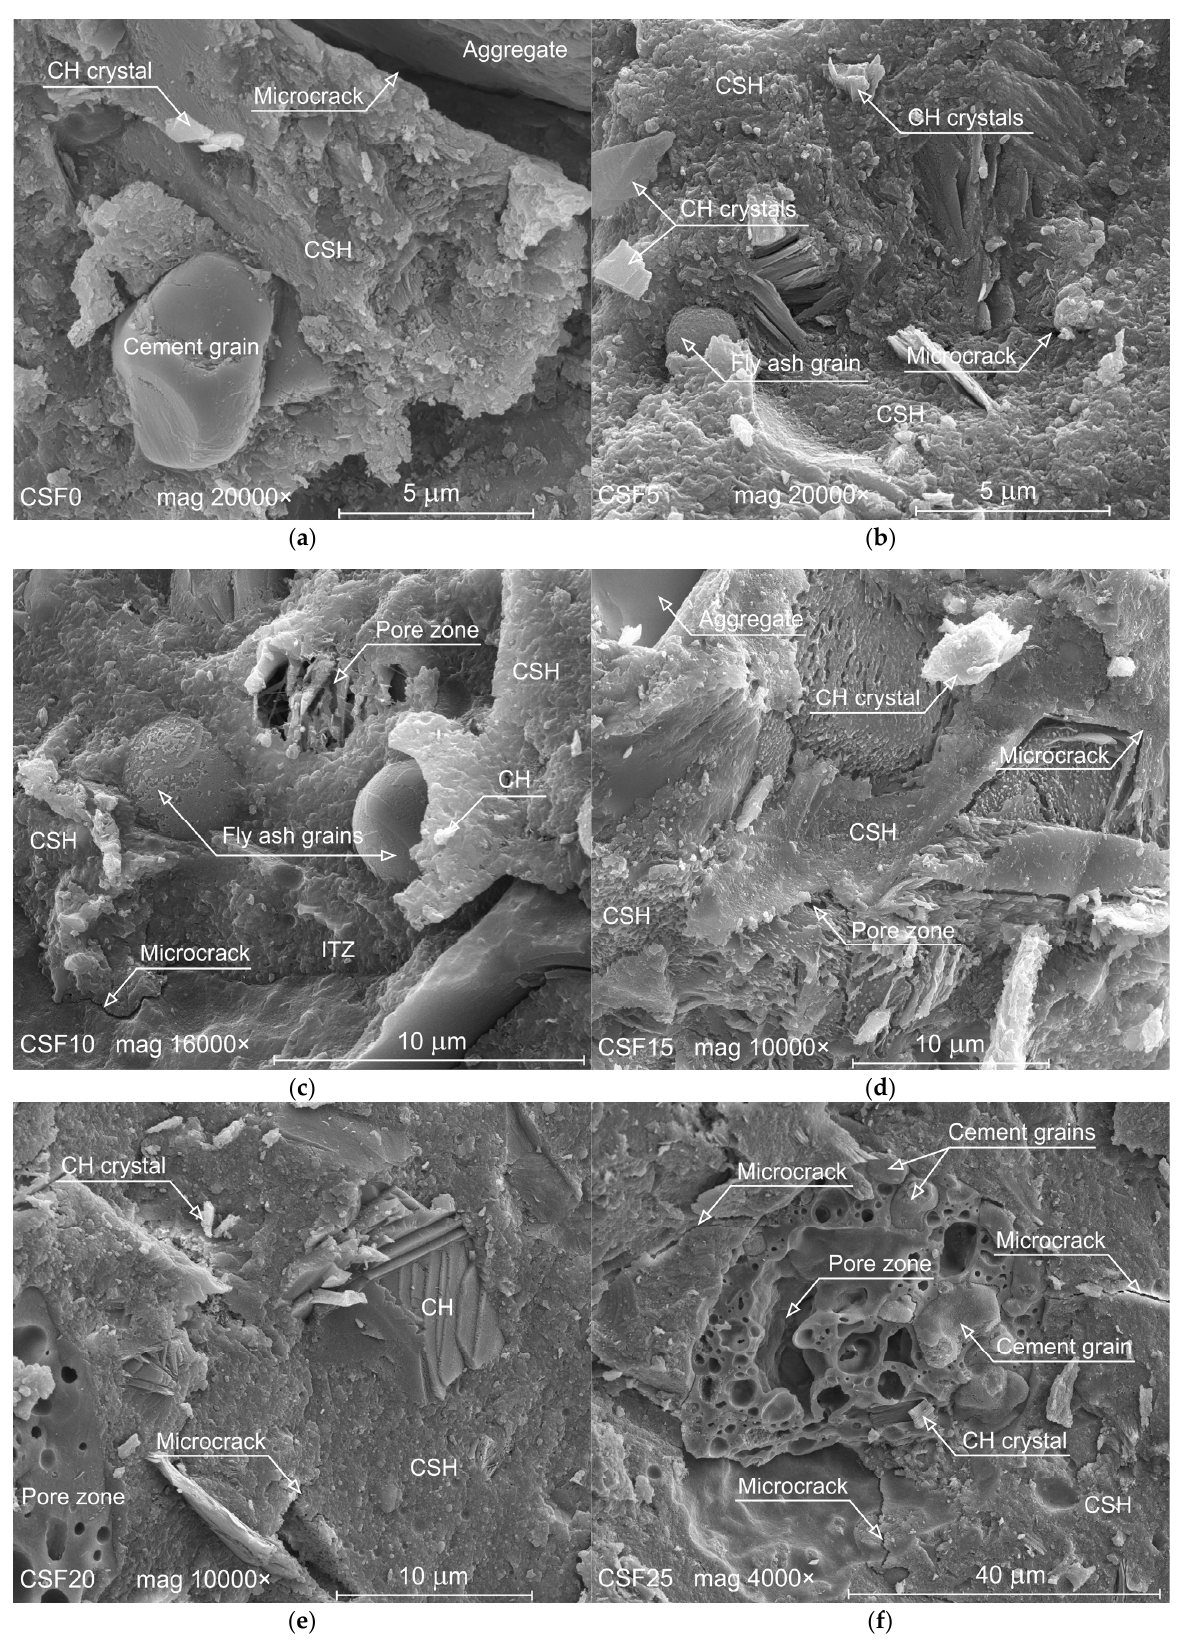
Figure 13. SEM microphotographs in magnification from 4000× to 20,000× for HPC with CSF content of ( a ) 0%; ( b ) 5%; ( c ) 10%; ( d ) 15%; ( e ) 20%; ( f ) 25%.